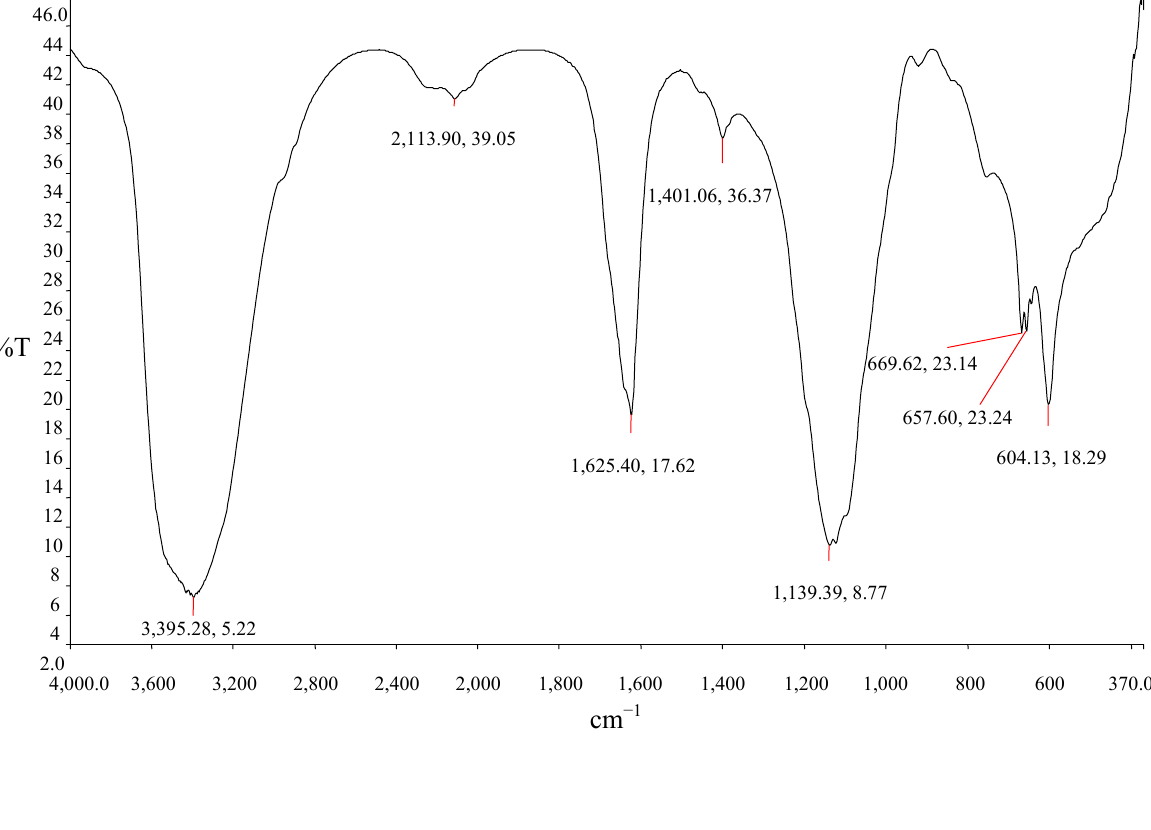
Figure 6. Fourier transform infrared (FTIR) spectroscopy of the purified